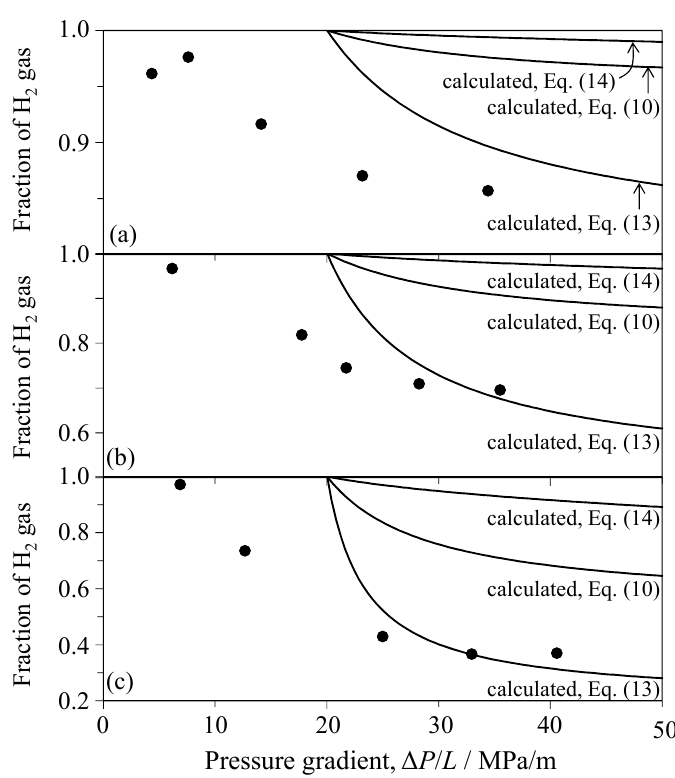
Figure 17. Comparison between measured and calculated H 2 fractions in the porous Al 2 O 3 ceramics for the supplied gas of ( a ) 80 vol % H 2 –20 vol % CO 2 ; ( b ) 50 vol % H 2 –50 vol % CO 2 , and ( c ) 20 vol % H 2 –80 vol % CO 2 .